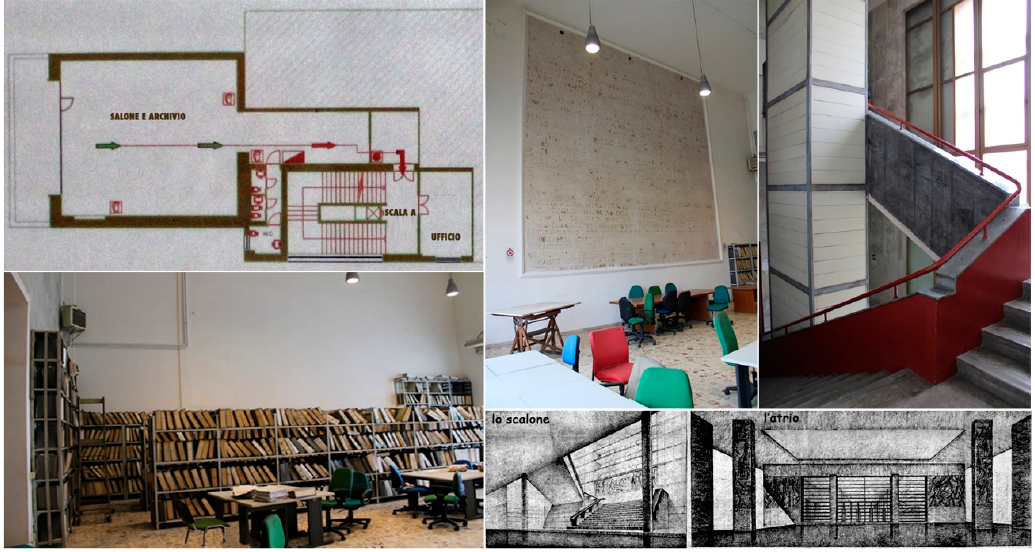
Figure 11. The transformations of the 1970s: the assembly hall becomes an archive and the main staircase welcomes an elevator that interrupts its monumentality.